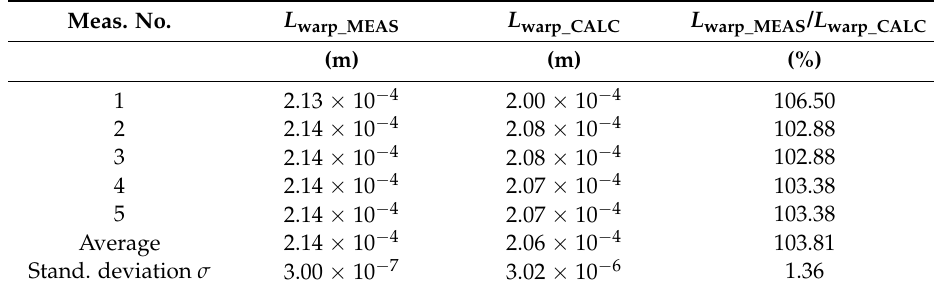
Table 12. The comparison of measurement and calculated results of the length of the warp-RSKCu+Ni. Meas. No.